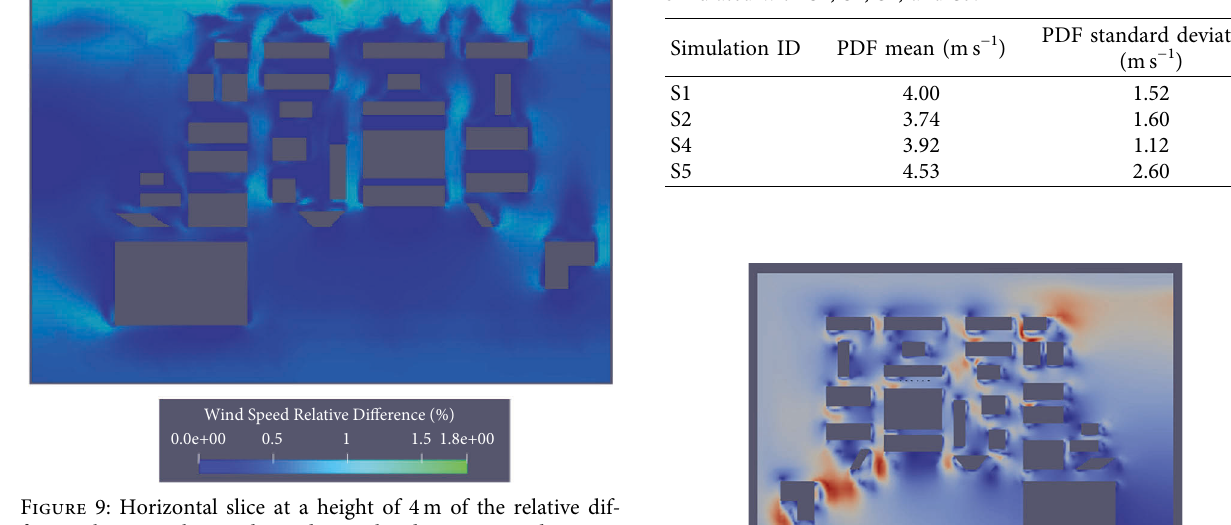
Figure 10: Probability Density Functions (PDFs) and histograms of wind speeds simulated with S1, S2, S4, and S5. Table 11: PDF mean and standard deviation of wind speeds simulated with S1, S2, S4, and S5.